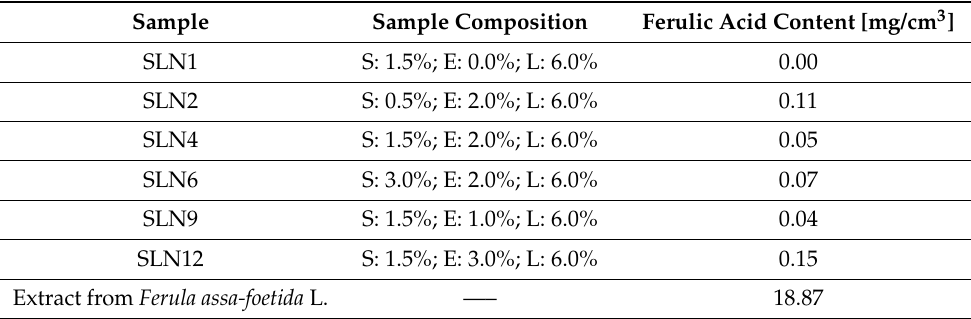
Table 6. Ferulic acid concentration evaluated on the basis of HPLC analysis. Sample Sample Composition Ferulic Acid Content [mg/cm 3